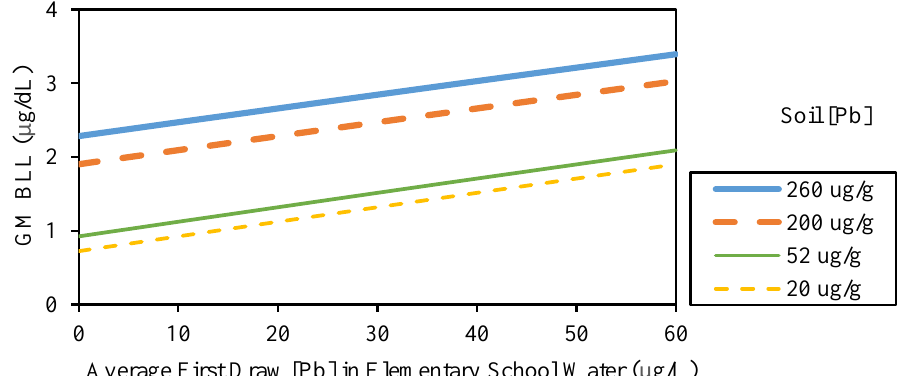
Figure 8. Predicted geometric mean BLL as a function of both the elementary school average first draw drinking water lead concentration and the region’s soil lead concentration according to the IEUBK model.